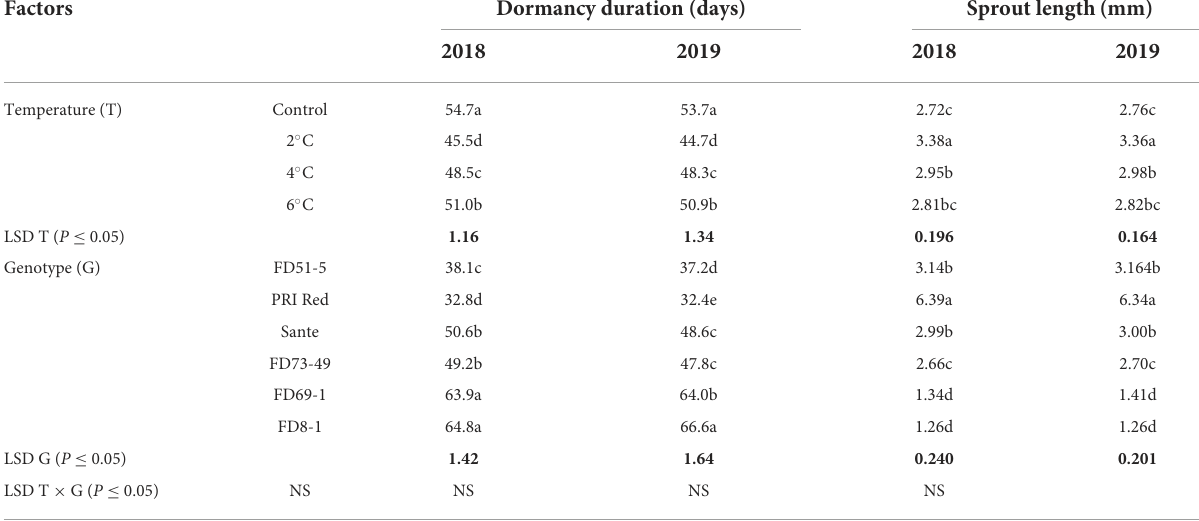
TABLE 4A Mean comparison of dormancy duration and sprout length of six potato genotypes tubers during 2018–2019 underwent low-temperature cold storage. Factors Dormancy duration (days) Sprout length (mm)